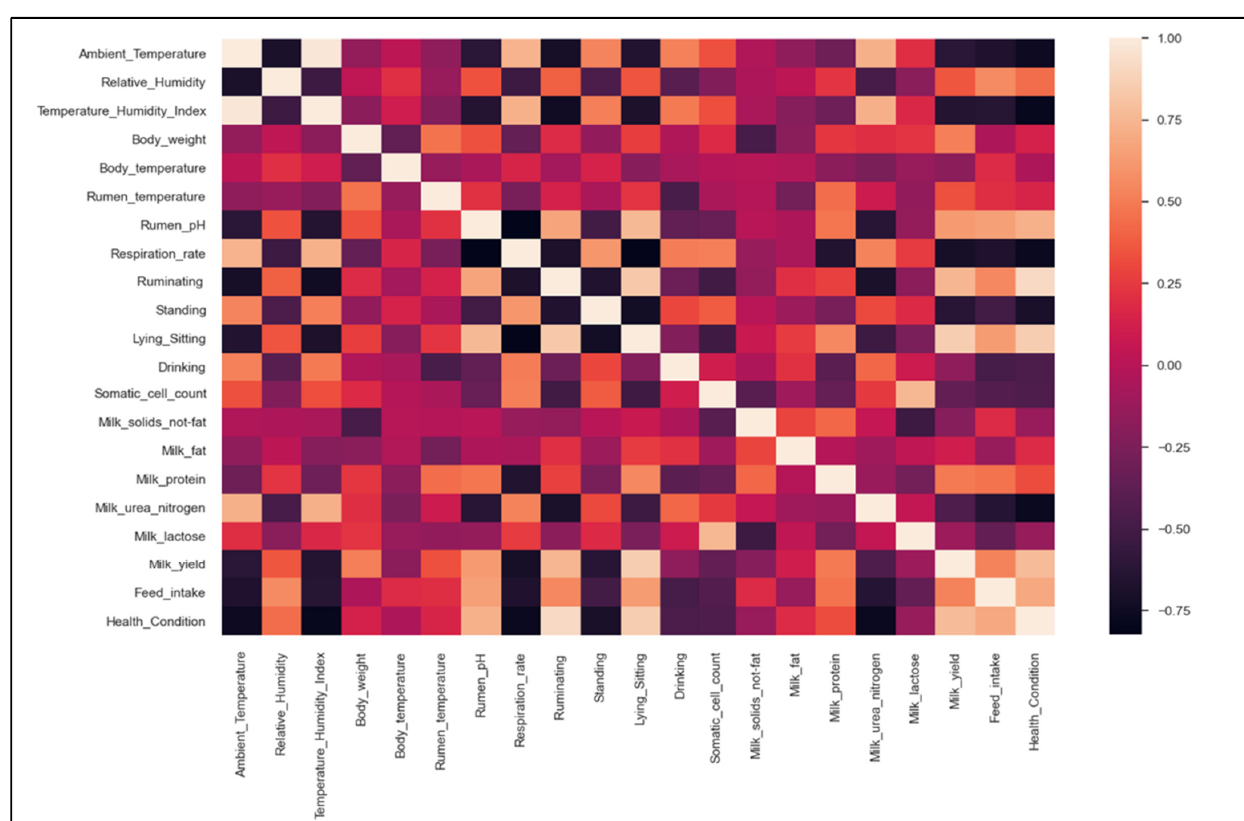
Figure 3. Pearson correlation of the parameters with the health condition of dairy cows.